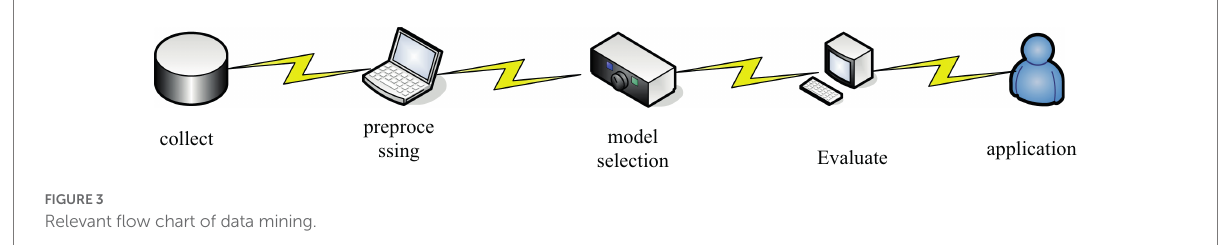
FIGURE 3 Relevant flow chart of data mining.